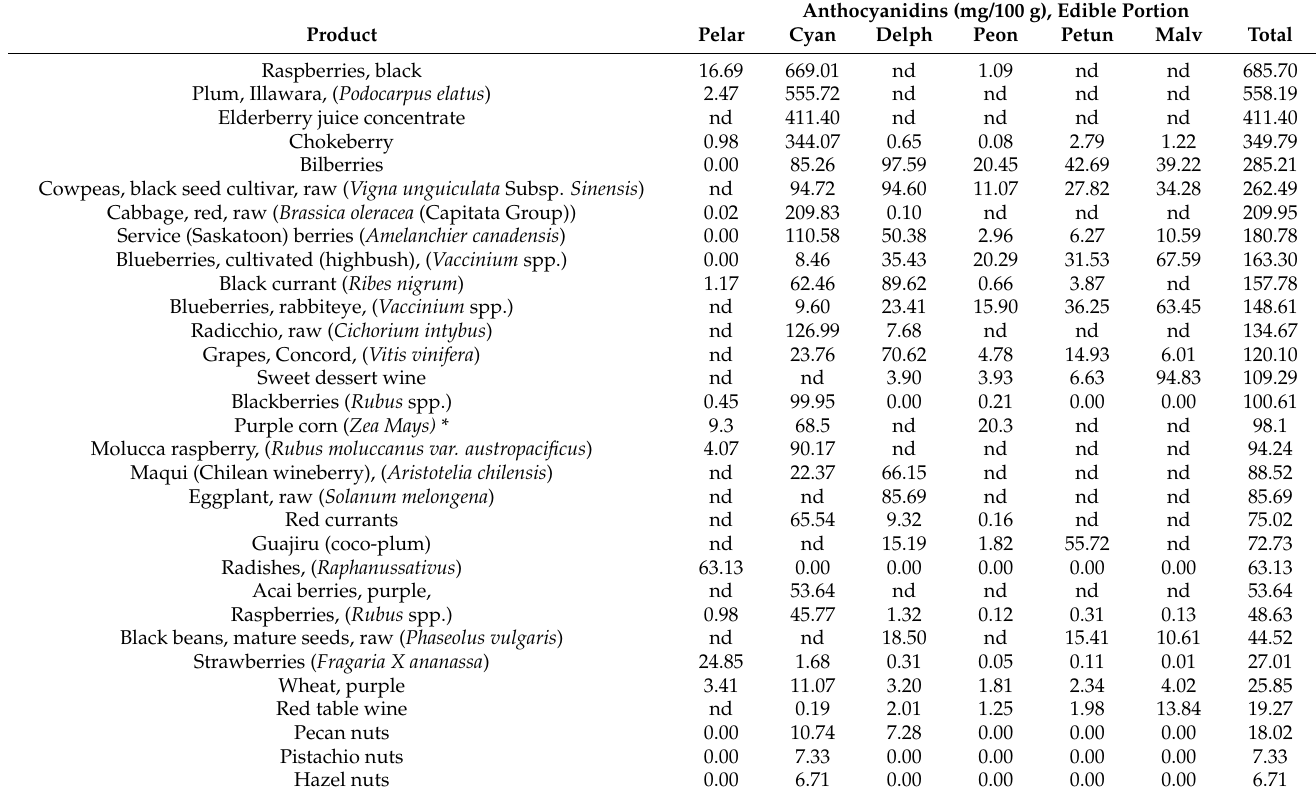
Table 1. Content of anthocyanidins in selected foodstuffs (mg per 100 g of foodstuff); based on